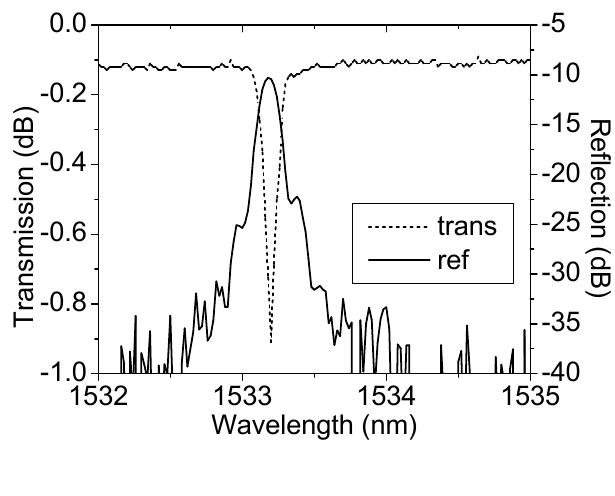
Figure 1. Transmission and reflection spectra for the seed grating used in this